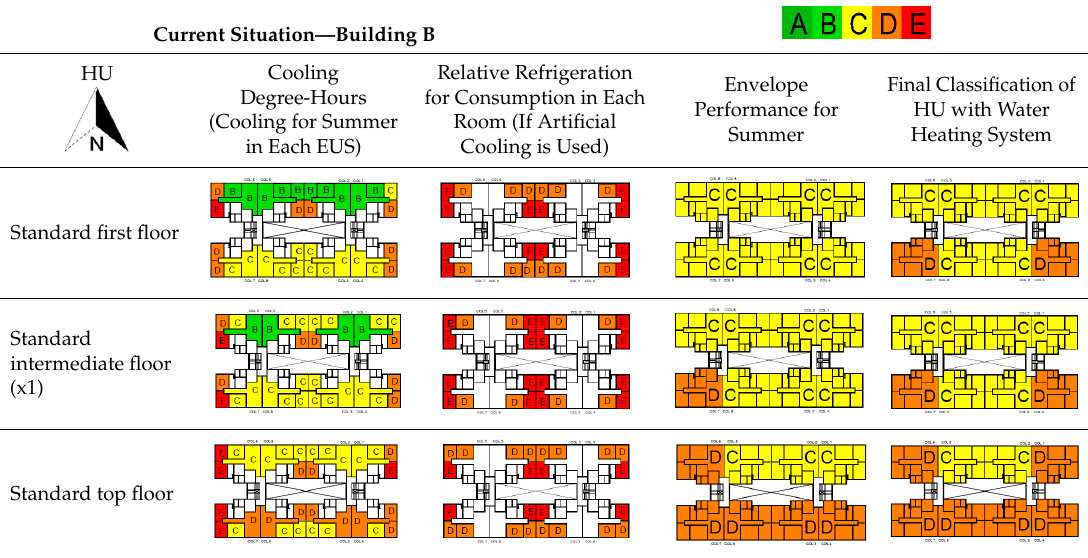
Table 7. Graphical representation of the standard floor of Representative Building C with the classification based on energy efficiency evaluation.